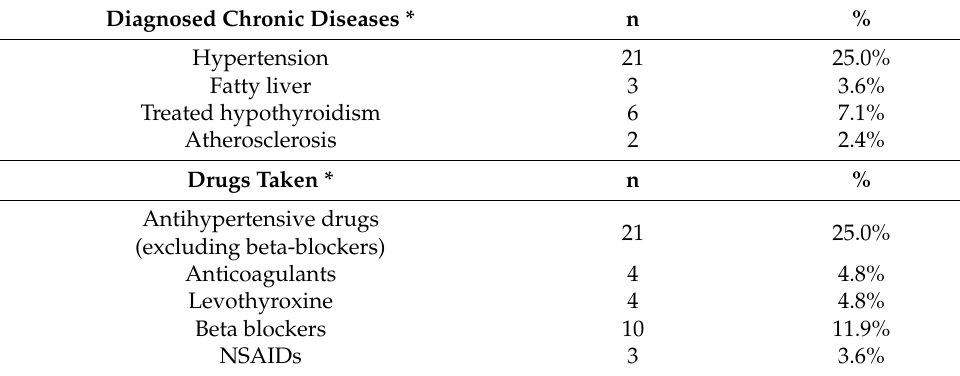
Table 1. Diseases and medications declared by